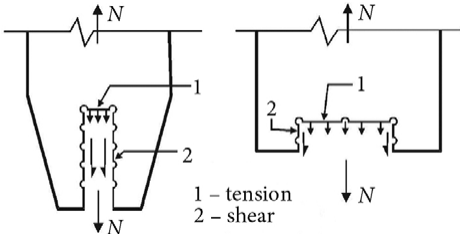
Fig. 7. Current concept of block shear in gusset